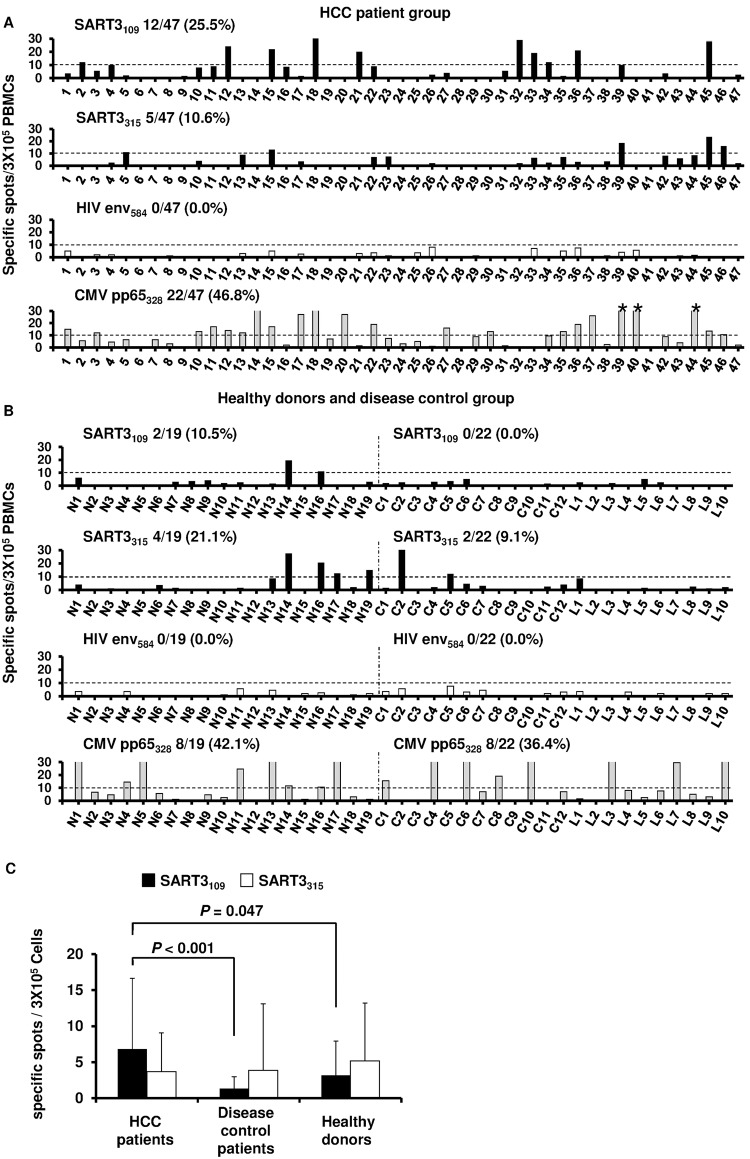
Immune responses of SART3-specific T cells in HCC patients.(A) Interferon (IFN)-γ enzyme-linked immunospot (ELISpot) assay was performed using SART3, HIVenv584, and cytomegalovirus pp65328-derived peptides with peripheral blood mononuclear cells (PBMCs) of HCC patients. % indicates the proportion of patients who showed positive responses. (B) IFN-γ ELISpot assay in healthy donors and disease control groups. “N” denotes normal donors. “C” denotes the patients with chronic hepatitis. “L” denotes the patients with liver cirrhosis. % shows the proportion of patients who exhibited positive responses. (C) Comparison of the mean number of SART3-derived peptide-specific spots among the three groups. Error bars indicate the standard deviations. Black and white bars indicate the frequencies of SART3109- and SART3315-specific T cells, respectively.